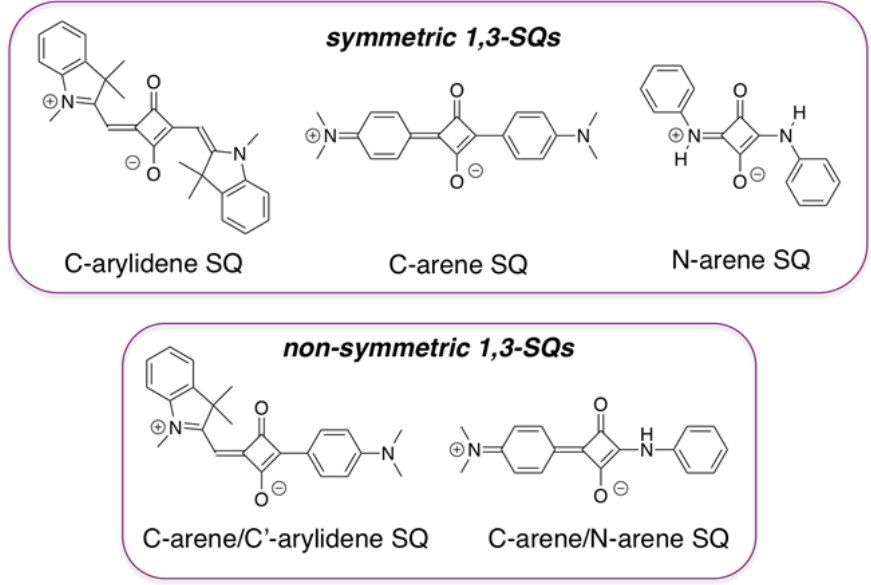
Figure 1. General structures of symmetric and non-symmetric 1,3-squaraines shown in the form of zwitterions. C, C’, and N indicate the nature of the bond that connects squaraine ring to the substituents.